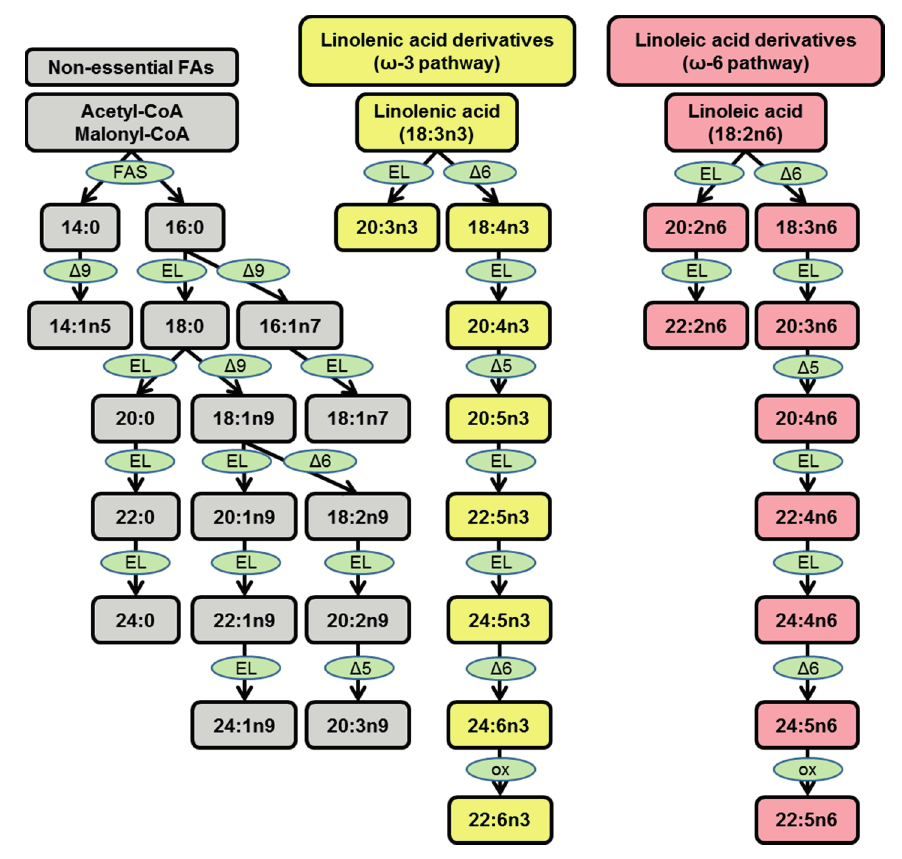
Figure 1. Fatty acid (FA) biosynthetic pathways and rabbit diet fatty acyl composition. ( A ) Schematic representation of three major FA biosynthetic pathways: Nonessential FAs (grey), ω -3 FAs (yellow), ω -6 FAs (lavender). Enzymes are depicted in light green; and ( B ) FA composition of rabbit diets. Regular chow (RC) and high cholesterol